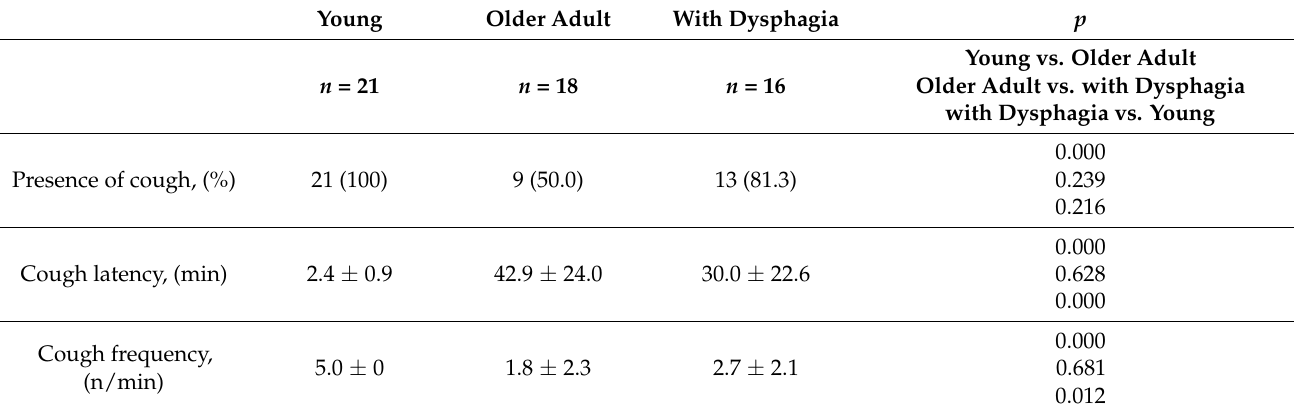
Table 2. Outcomes of all groups of the cough test.